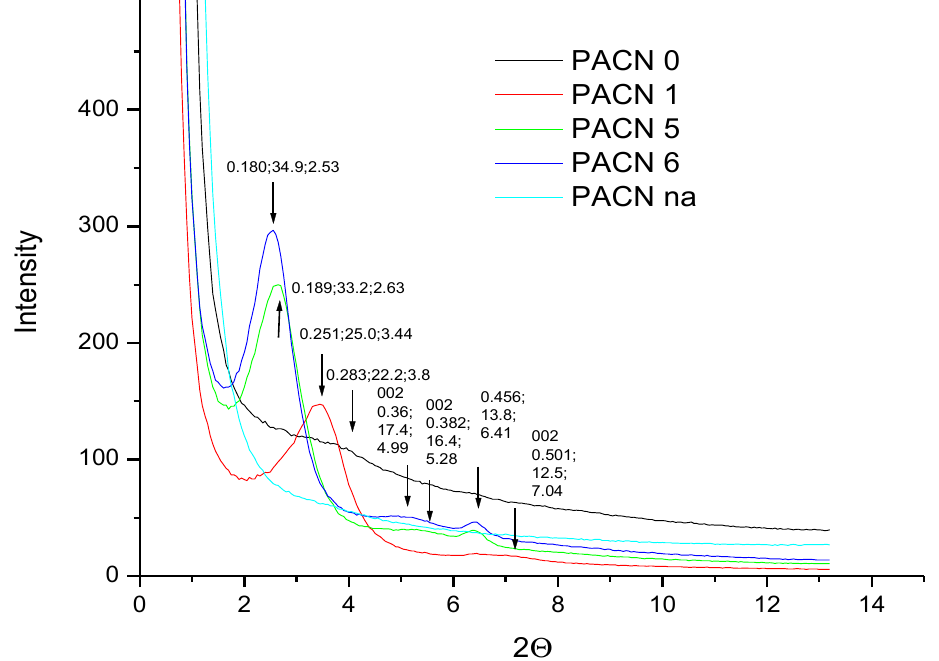
Figure 12. WAXS patterns for PACN synthesized with oxidant wt.% of 0.8 (PACN6), 0.7 (PACN 5), 0.1 (PACN 1), 3.5 and 3 wt.% clay (PACN0), and 3.5 and 5% clay (PACNna).